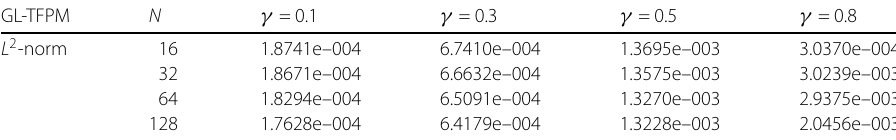
Table 1 The L 2 -norm error of GL-TFPM